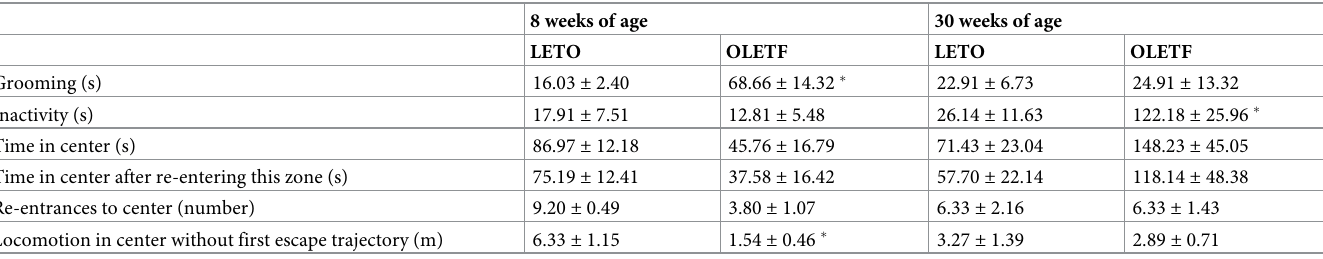
Table 1. Behavioral assessments in the open field